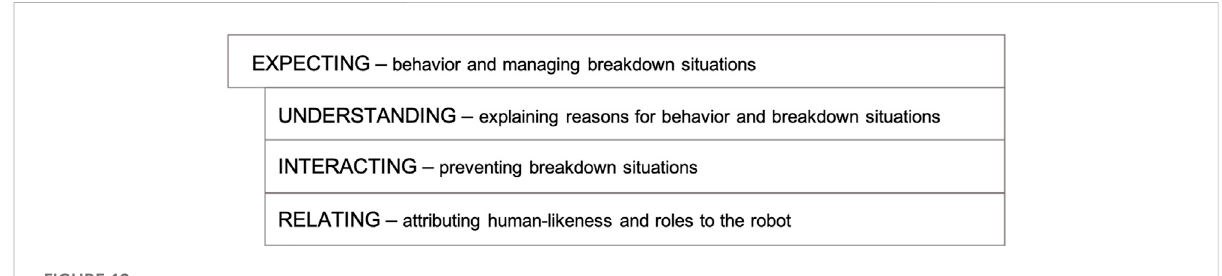
FIGURE 12 Overview of the emerging themes describing how participants perceive and understand breakdown